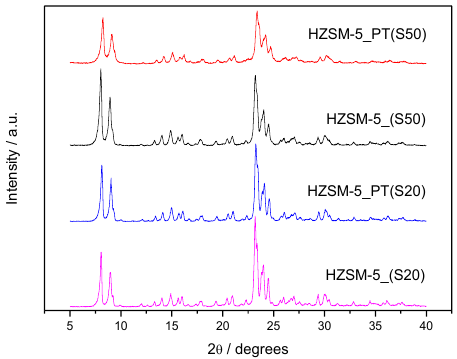
Figure 1. X-ray di ff ractograms of parent (HZSM-5_(S50) and HZSM-5_(S20)) and post-treated Figure 1. X-ray diffractograms of parent (HZSM-5_(S50) and HZSM-5_(S20)) and post-treated (HZSM-5_PT(S50) and HZSM-5_PT(S20)) (HZSM-5_PT(S50) and HZSM-5_PT(S20)) zeolites.